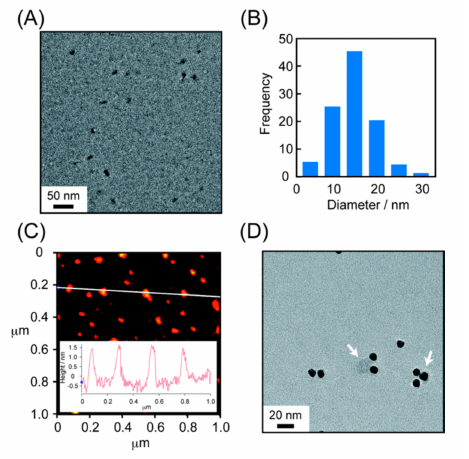
Figure 3. Characterization of self-assembled peptide nanocarriers of Entry 1 prepared by incubation at 25 ◦ C for 6 h ([peptide] = 100 µ M in 20 mM sodium phosphate buffer, 150 mM NaCl, pH 7.2). ( A ) Transmission electron microscopy (TEM) image of the self-assembled peptide nanocarriers; ( B ) distribution in diameters of the nanocarriers in TEM images; ( C ) atomic force microscopic (AFM) analysis of the nanocarriers; and ( D ) localization of the NLS-moieties of the nanocarriers by immunostaining with gold colloidal particle (10 nm)-labeled goat anti-biotin antibody. Black spheres show gold nanoparticles and white arrows indicate self-assembled peptide nanocarriers colored in gray in panel three-dimensional (3D). TEM samples were negatively stained with 2% phosphotungstic